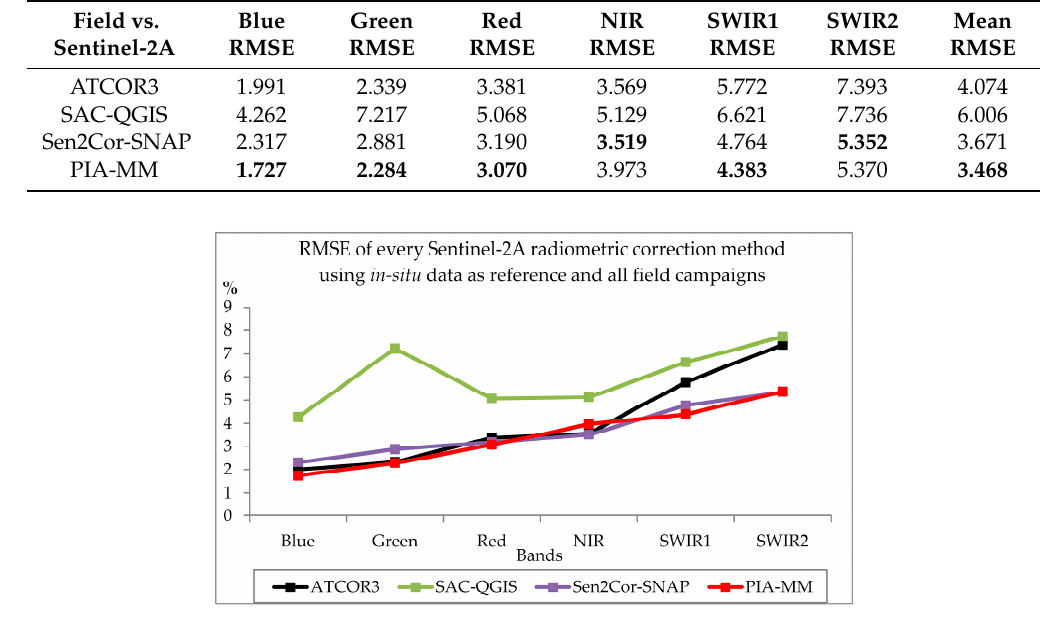
Figure 11. Band-by-band Root Mean Square Error of each radiometric correction method analyzed for Sentinel-2A images, grouping all dates.